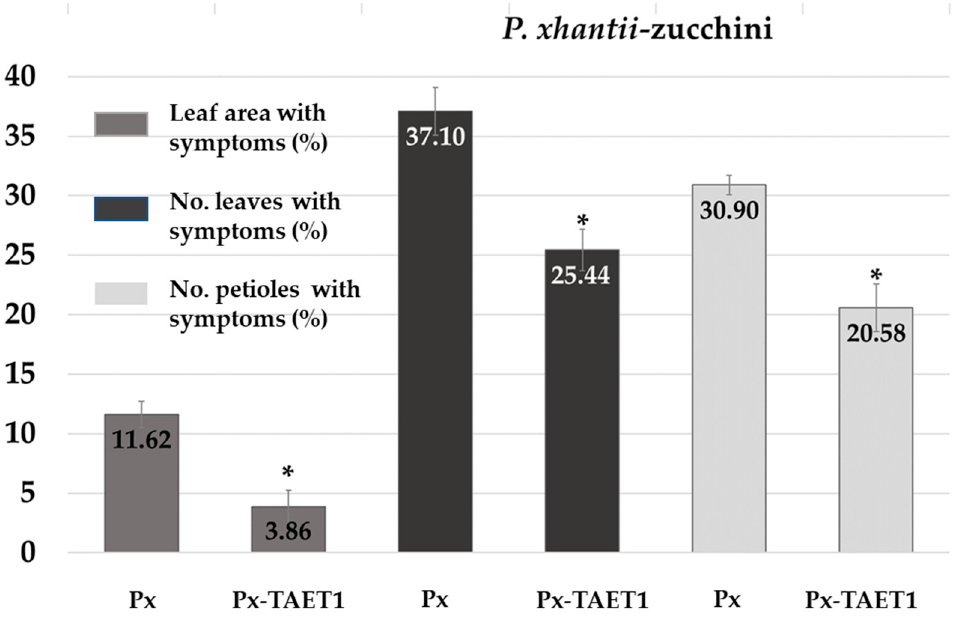
Figure 9. Control of P. xanthii by spraying zucchini plants with TAET1. Mean proportion of leaf area with powdery mildew symptoms per plant, percentage of the number of leaves with symptoms per plant, and percentage of number of petioles with powdery mildew. Px: Application of P. xanthii . Px-TAET1: application of TAET1 3 days before application of P. xanthii . Data were tested using Student’s t -test. * significant at p <